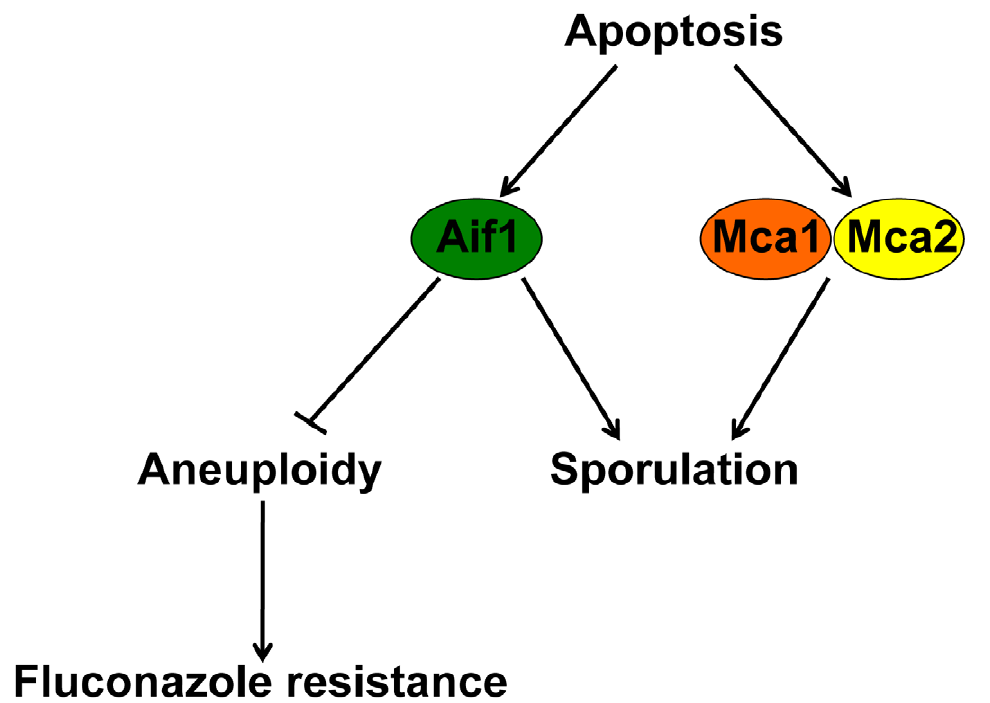
Figure 8. Mechanisms controlling ALCD, mating, and aneuploidy. Both Aif1 and the metacaspases are required for sporulation in C. neoformans . The Aif1-mediated ALCD eliminates aneuploid cells from the population and contributes to the emergence of FLC R